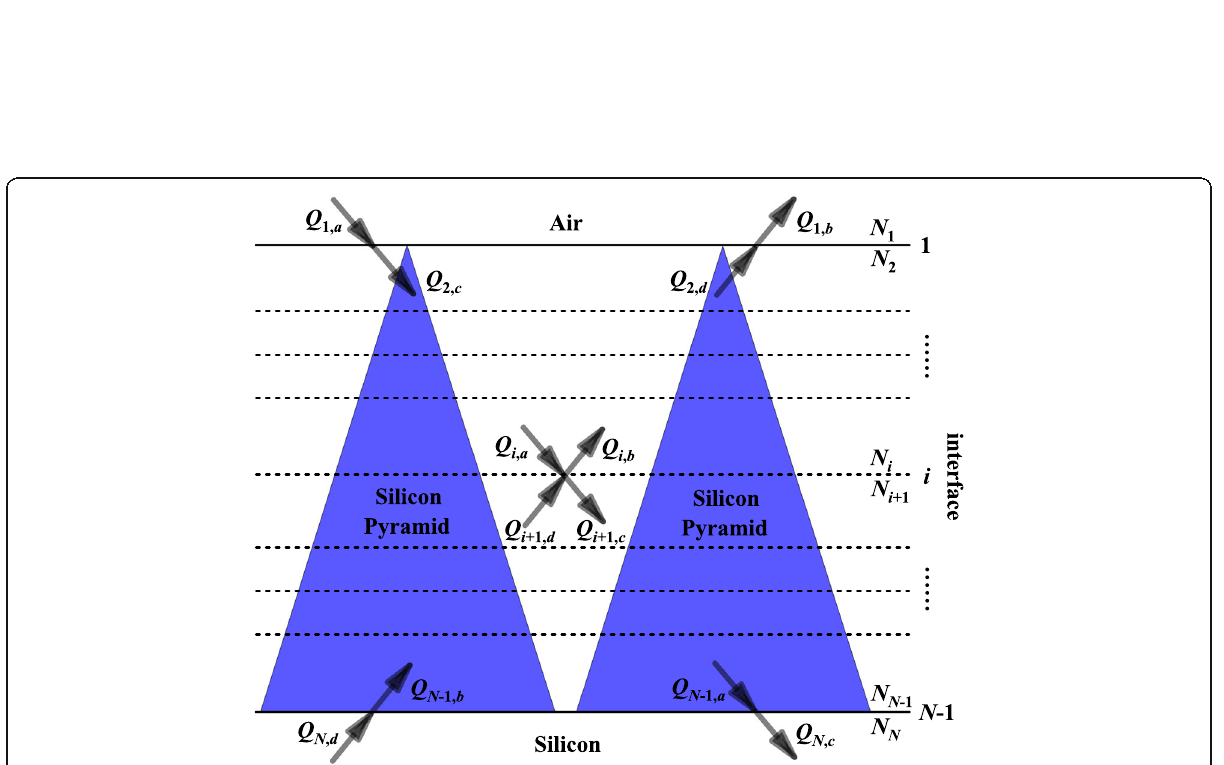
Fig. 2 Schematic multilayer medium structure of the silicon pyramid gratings, with numbering convention of interfaces (1, … , i , … , N − 1), complex refractive index ( N 1 , … , N i , … , N N ), and electromagnetic radiation fluxes ( Q i , a , Q i , b , Q i +1, c , Q i +1, d , …